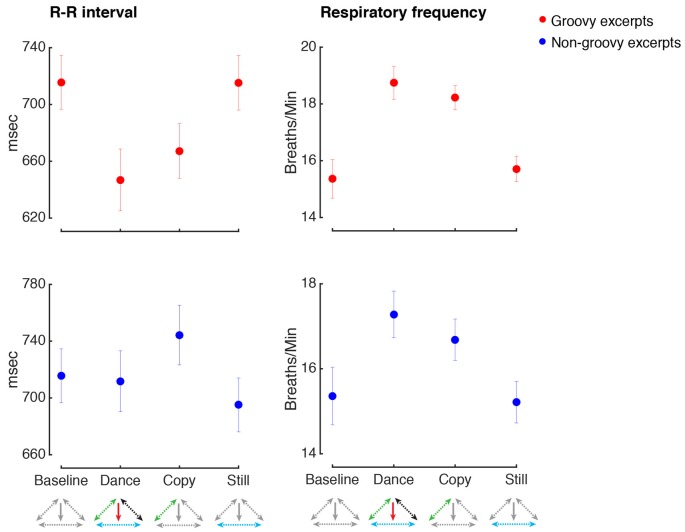
Physiological arousal. All conventions as in Figure 4. The R-R interval indicates the time elapsed between successive heart beats, with higher R-R intervals indicating slower heart rate.